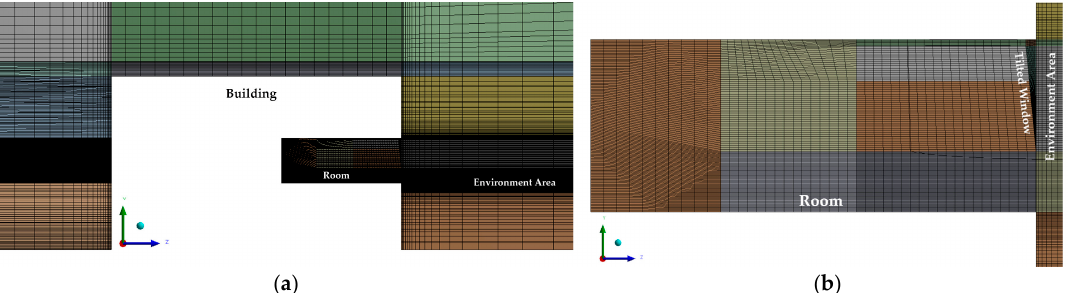
Figure 6. Computational mesh of: (a) entire domain, (b) area between external environment, room and tilted window.